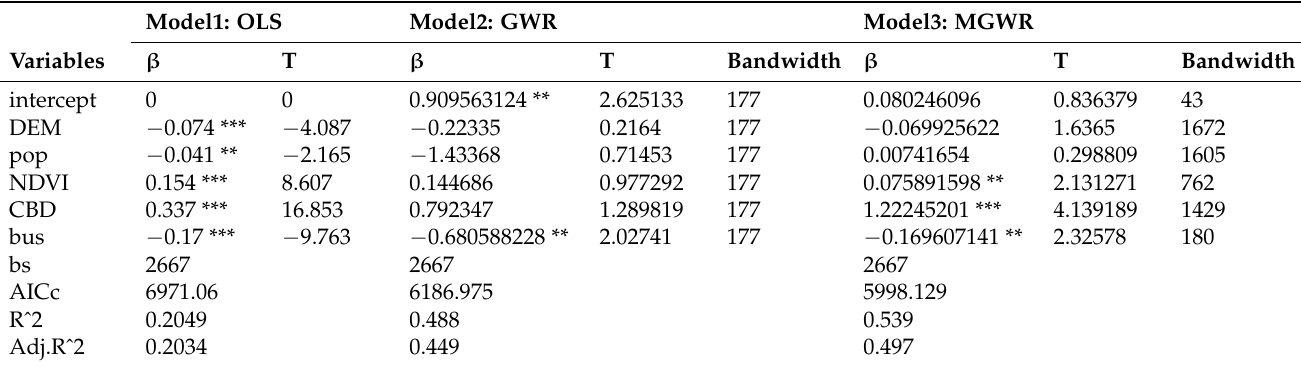
Table 3. Model results of OLS, GWR, and